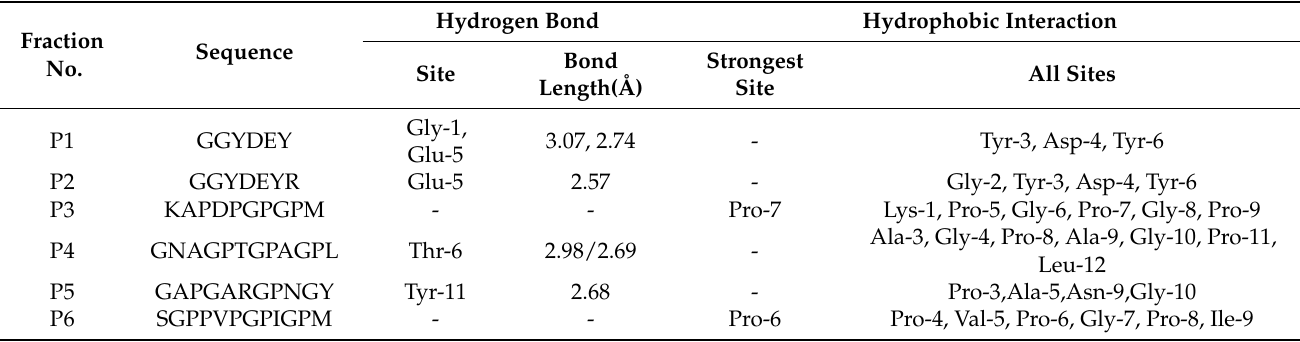
Figure 4. Molecular docking model 2D display to identify the interaction of synthetic antioxidant peptides with ABTS. ( a ) P1; ( b ) P2; ( c ) P3; ( d ) P4; ( e ) P5; ( f ) P6. Amino acid residues surrounding the active peptides involved in the interaction are marked with different colours (green for hydrogen bonds and red for hydrophobic interactions) for ease of observation. Interactions between peptides and ABTS are marked with dashed lines in different colours (purple for regular hydrogen bonds and red for strong hydrophobic bonds). Table 4. Summary of molecular docking results between peptides identified from tilapia skin and ABTS + free